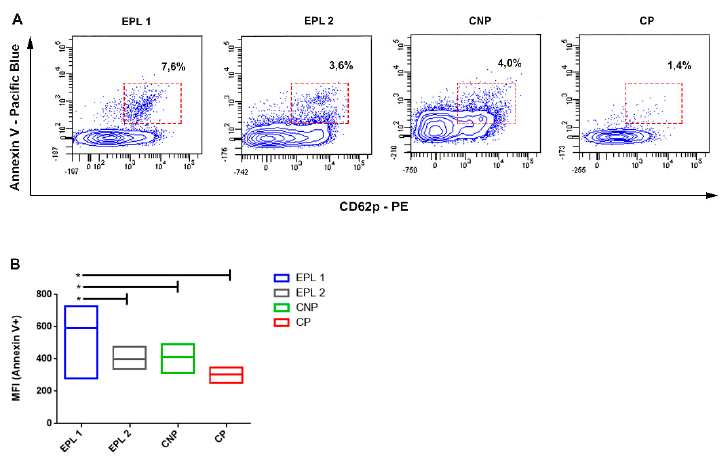
Figure 4. Flow cytometric analysis of platelets released microparticles in the studied groups ( A ); mean fluorescence intensity (MFI) showing changes in annexin V expression ( B ); T-test * p ≤ 0.05.